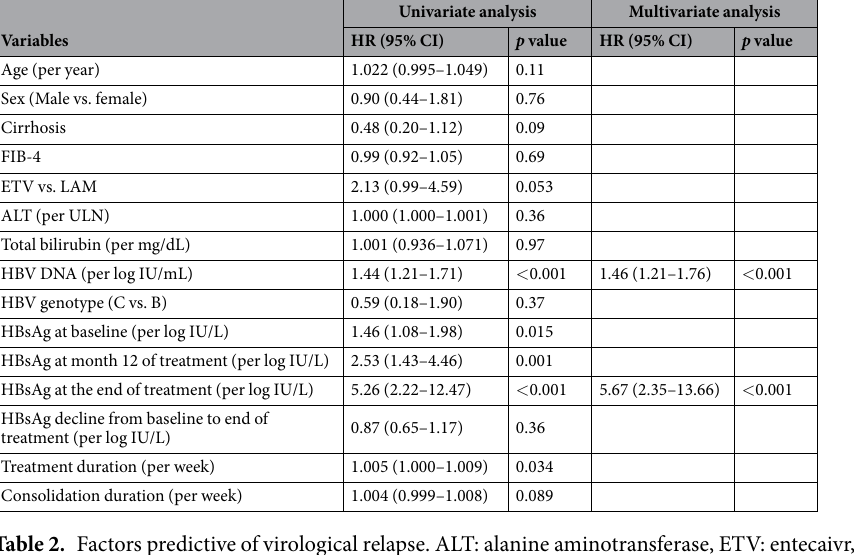
Table 2. Factors predictive of virological relapse. ALT: alanine aminotransferase, ETV: entecaivr, LAM: lamivudine, HR: hazard ratio, CI: confidence